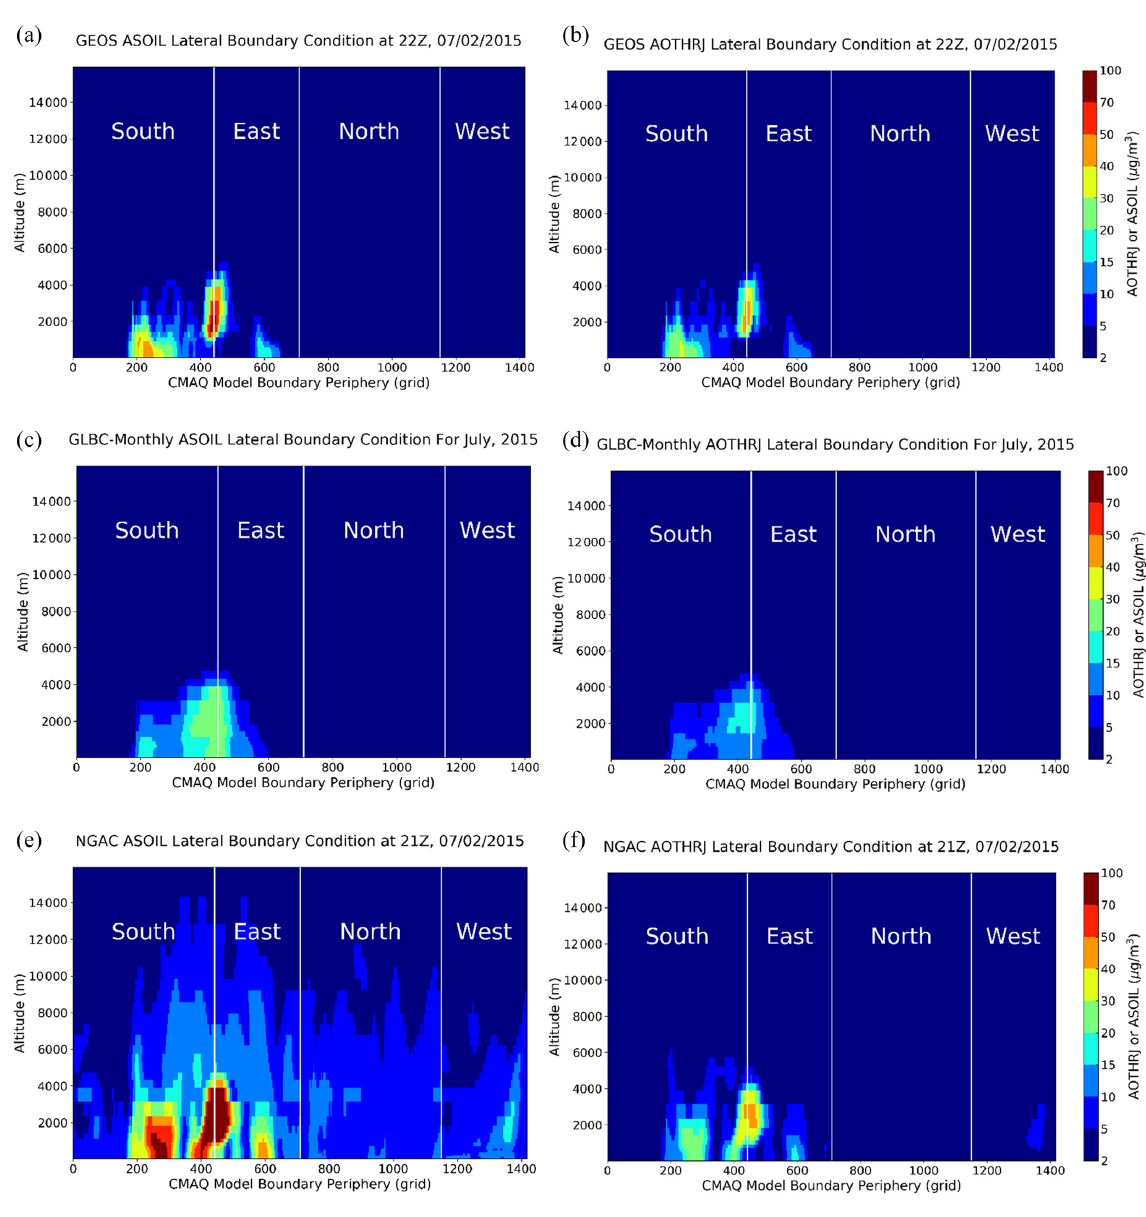
Figure 3. The lateral boundary conditions for ASOIL (a, c, e) and AOTHRJ (b, d, f) along the domain periphery for 2 July 2015. The CMAQ LBC’s grid index for each LBC segment is always from south to north and then from west to east, so the LBC index’s start points are reset instead of being continuous for the north and west boundaries. Please note that the dates in this figure are given in the format of month day year